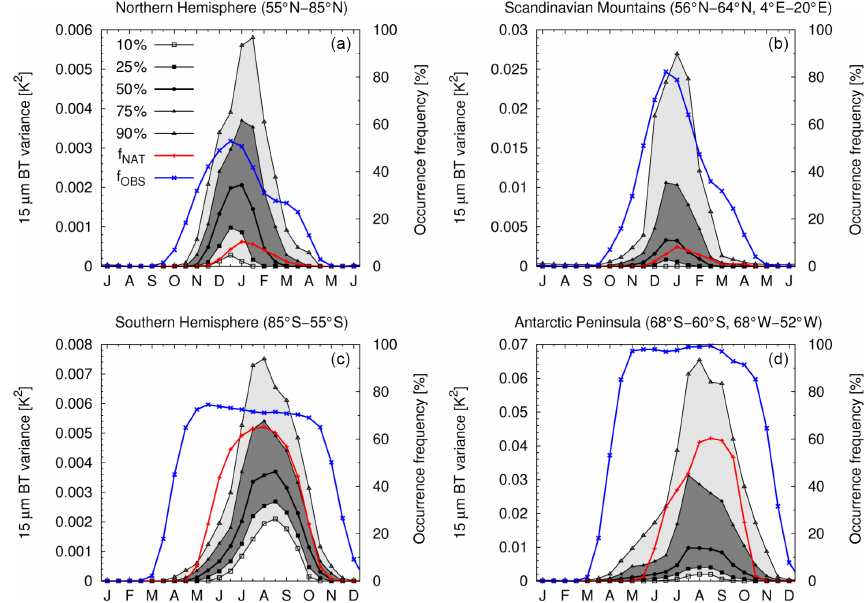
Figure 6. Seasonal cycle of gravity wave activity at northern (top left) and southern (bottom left) mid- and high latitudes as well as the Scandinavian Mountains (top right) and the Antarctic Peninsula (bottom right) from AIRS observations from 2003 to 2012. The gravity wave activity within 30-day time windows is measured in terms of 10, 25, 50, 75, and 90% quantiles of 15µm brightness temperature variances. The red curves show the occurrence frequencies f NAT of ERA-Interim 60hPa temperatures falling below T NAT . The blue curves show the occurrence frequencies f OBS of 30hPa zonal winds exceeding a threshold of 20ms − 1 . Please note the different scales on the y